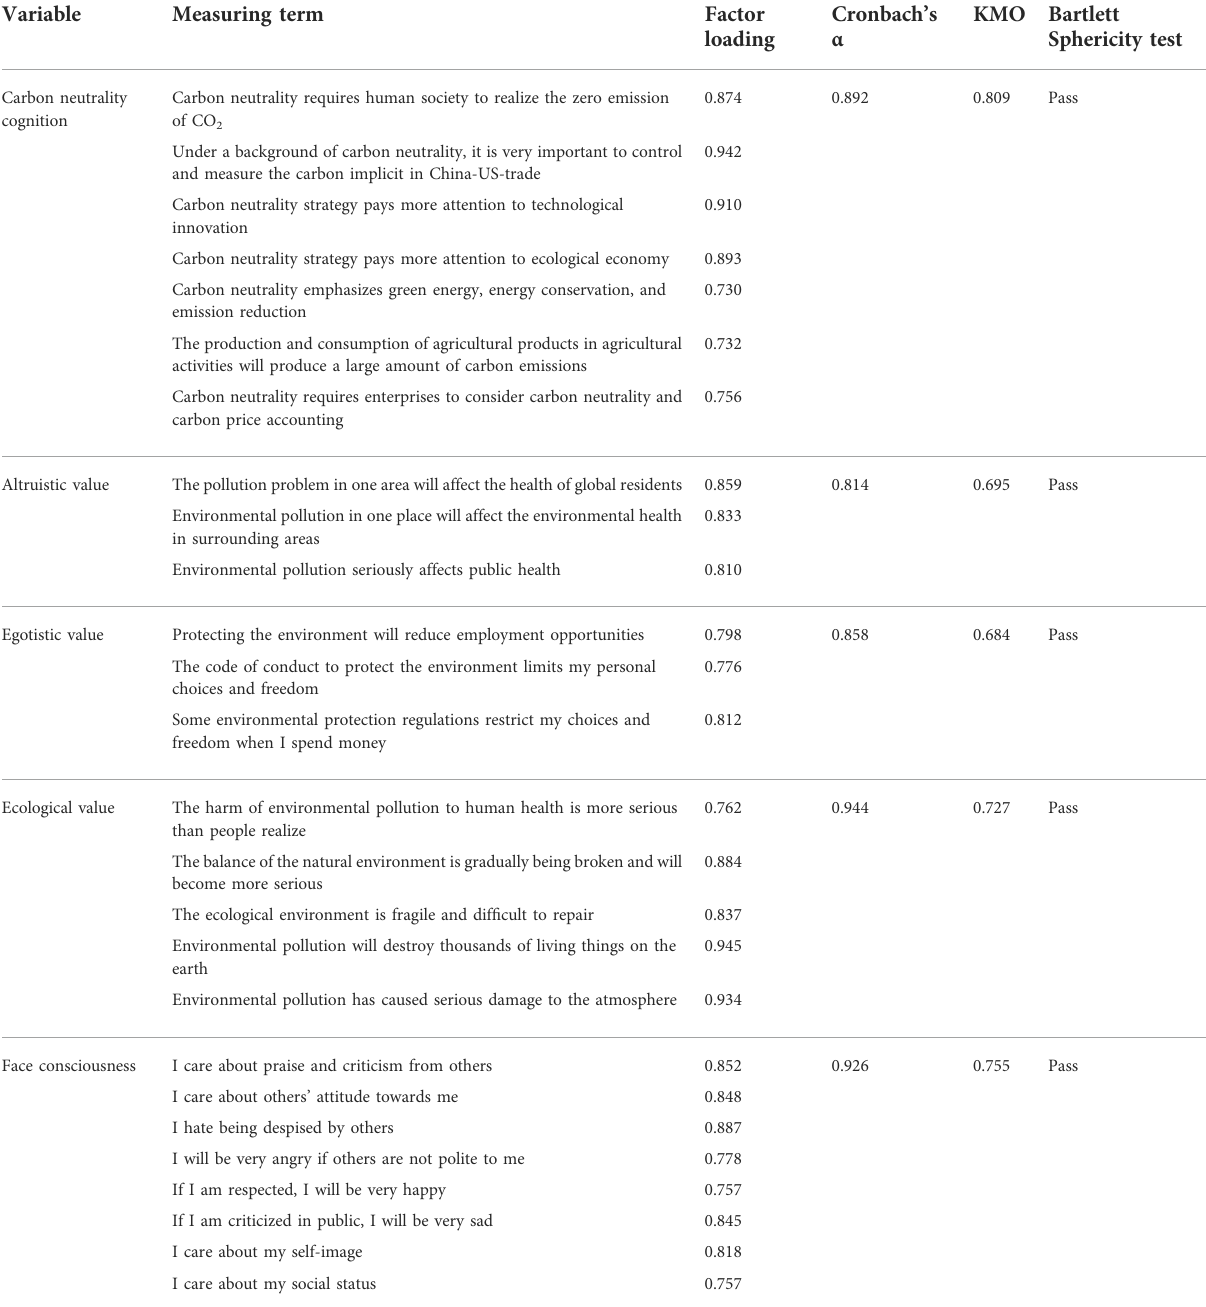
TABLE 2 Measurement indicators, reliability, and validity of the